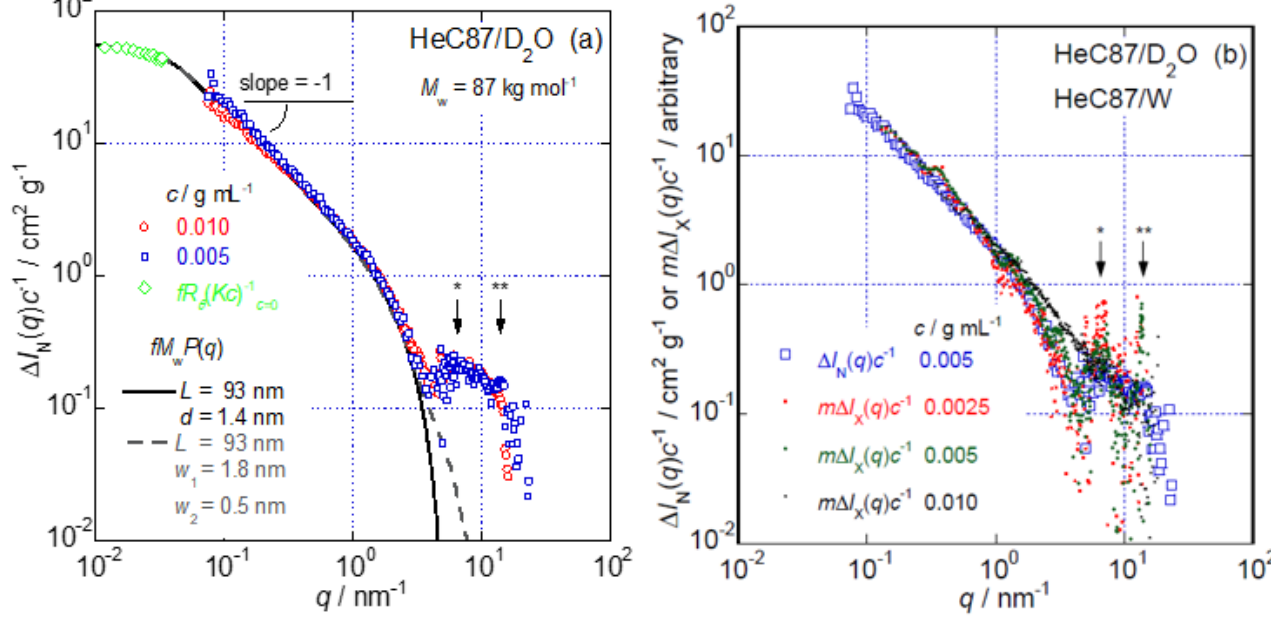
Figure 5. ( a ) q dependencies of the ∆ I N ( q ) c − 1 (S-WANS) data for D 2 O solutions of HeC87 at c = 0.005 and 0.010 g mL − 1 at 25 ◦ C; ( b ) q dependencies of the m ∆ I X ( q ) c − 1 (S-WAXS) data for aqueous HeC87 solutions at c = 0.0025, 0.0050 and 0.010 g mL − 1 at 25 ◦ C and that of ∆ I N ( q ) c − 1 data for the same HeC87 sample shown in ( a ). The SLS data obtained for the same system, fR θ ( Kc ) − 1 , and the two fit curves, fM w P ( q ), obtained assuming f = 6.5 × 10 − 4 cm 2 g − 2 mol, are also shown in ( a ). The numerical constant of m = 0.17 is used for all the m ∆ I X ( q ) c − 1 data in ( b ). The places of * and ** in the figures mean the positions of the broad interference-type peaks.